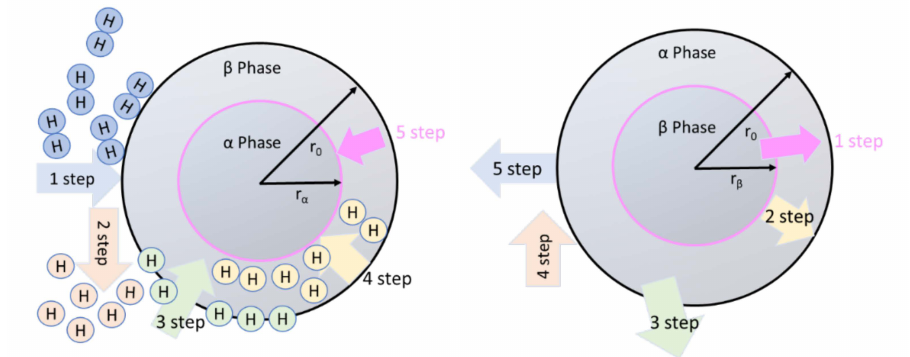
Figure 3. Hydrogen absorption steps ( left ) and desorption ( right ) by a